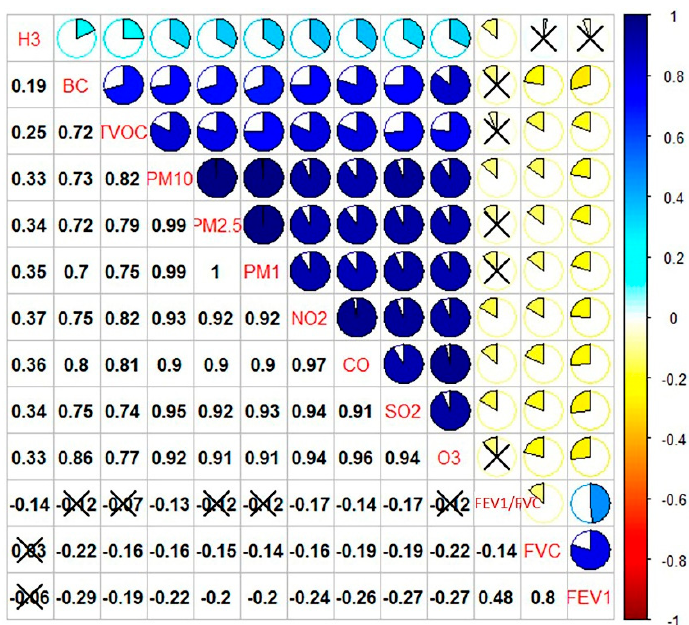
Figure 4. Correlations between TRAP concentrations and histone H3 level.